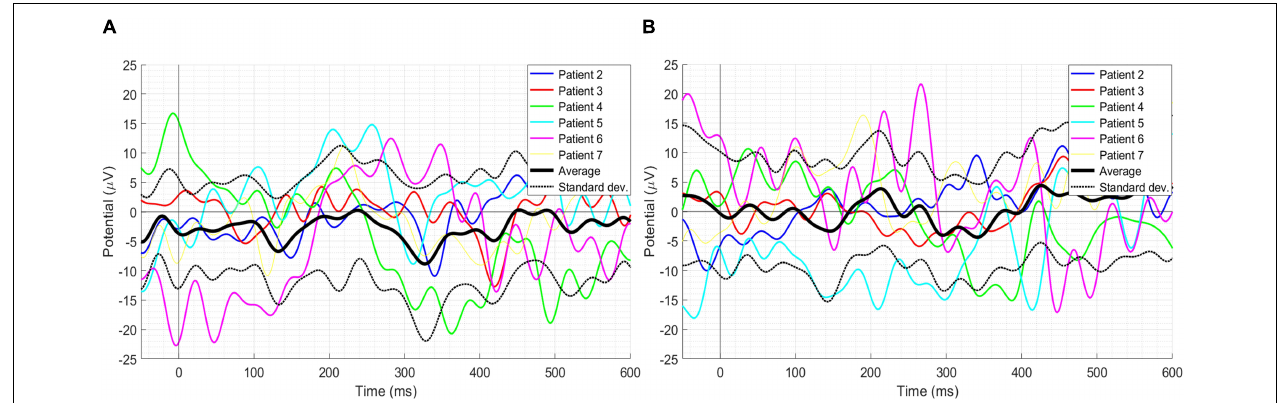
FIGURE 5 | (A) The grand-average ERPs with its SD as well as individual ERPs of the 2-s failure trials. (B) The grand-average ERPs with its SD as well as individual ERPs of the 4-s failure trials. Results of only the first six patients have been shown to prevent over-burdening the figure, while we got similar outcomes for each of the 13